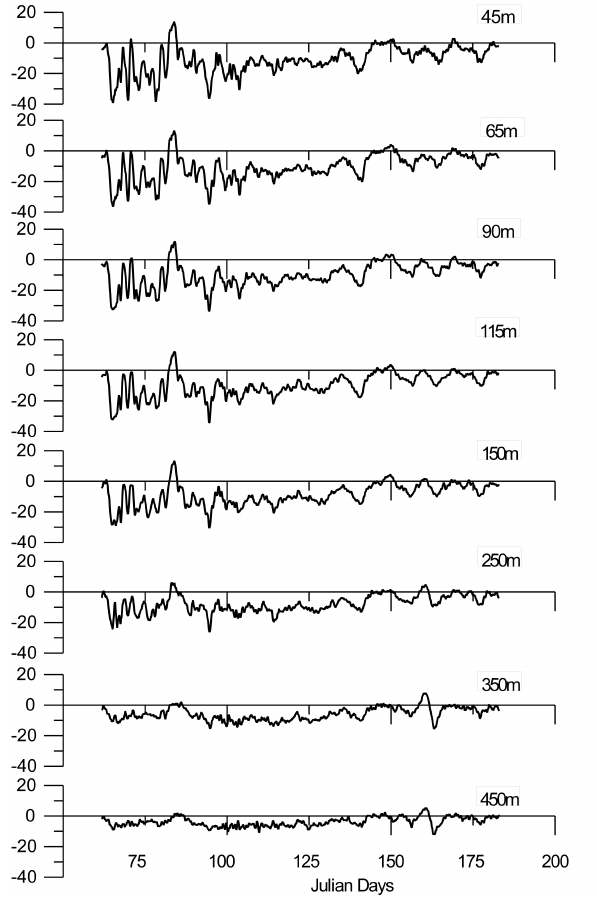
Fig. 8. Meridional velocities (cm/s) at different levels for the first period (04 March 2000–01 July 2000; J.D. 64 – J.D. 183). barotropic-like down to 250 m with a constant vertical